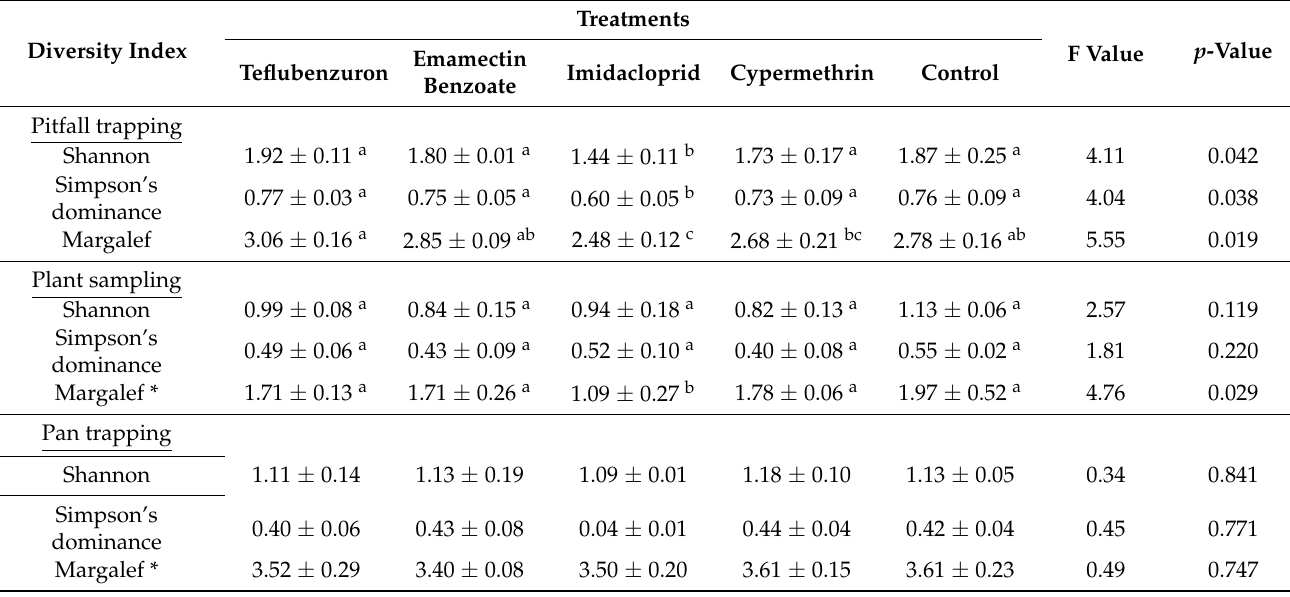
Table 1. Diversity index (mean ± standard deviation) of morphospecies, according to the sampling methodology applied, collected after the first insecticide treatment (sampling period between 24 September 2017 and 11 December